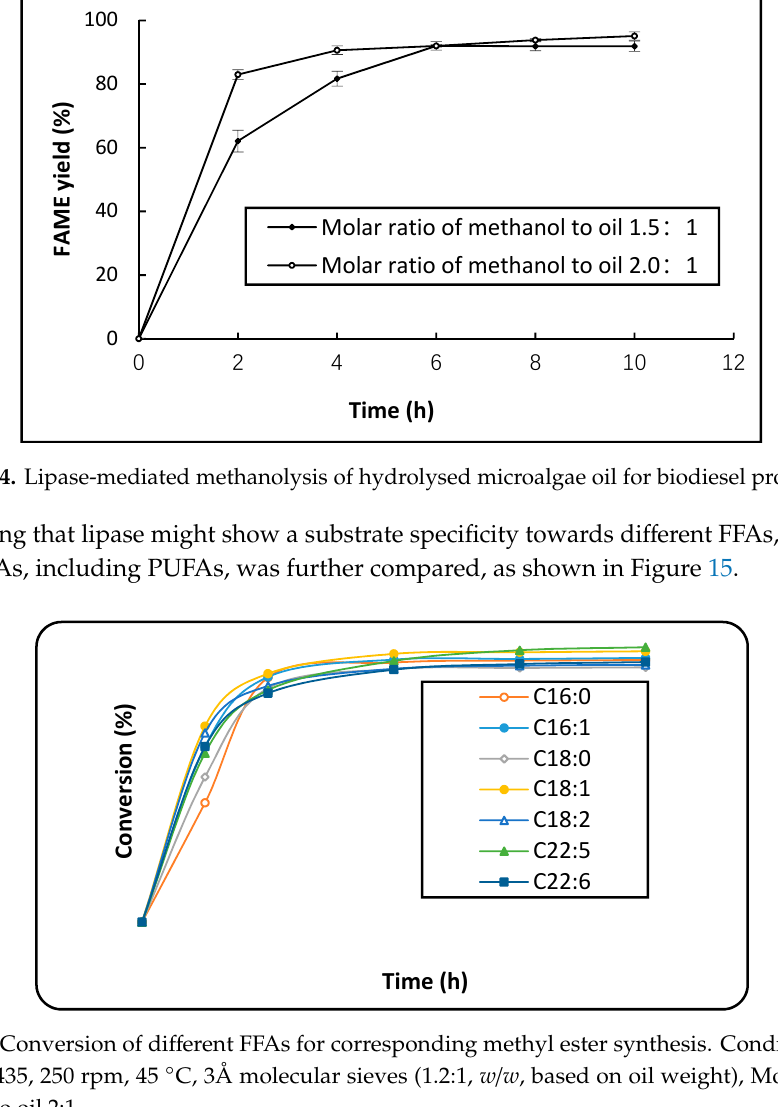
Figure 15. Conversion of different FFAs for corresponding methyl ester synthesis. Conditions: 1.5% Novozym435, 250 rpm, 45 °C, 3Å molecular sieves (1.2:1, w/w, based on oil weight), Molar ratio of